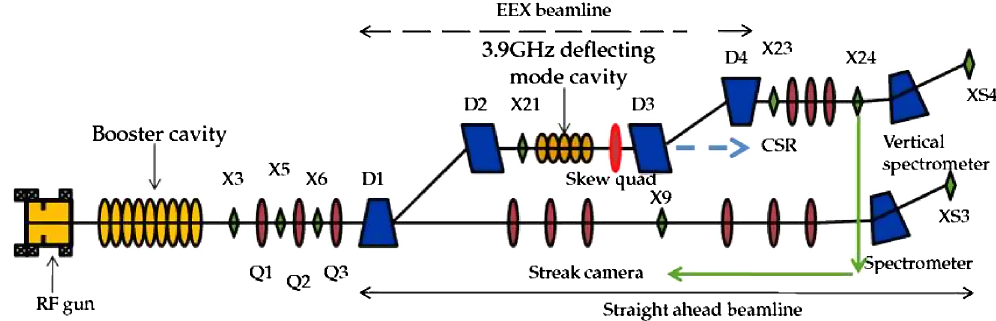
FIG. 1. Experimental setup of the A0 photoinjector facility. Electrons generated by the rf gun are accelerated through the booster cavity to 14 MeV. Q1, Q2, and Q3 focus the beam before it enters the EEX beam line. D1, D2, D3, and D4 are the dipole magnets. The skew quadrupole located before D3 is used to study time-resolved effects. X# refers to beam imaging stations.